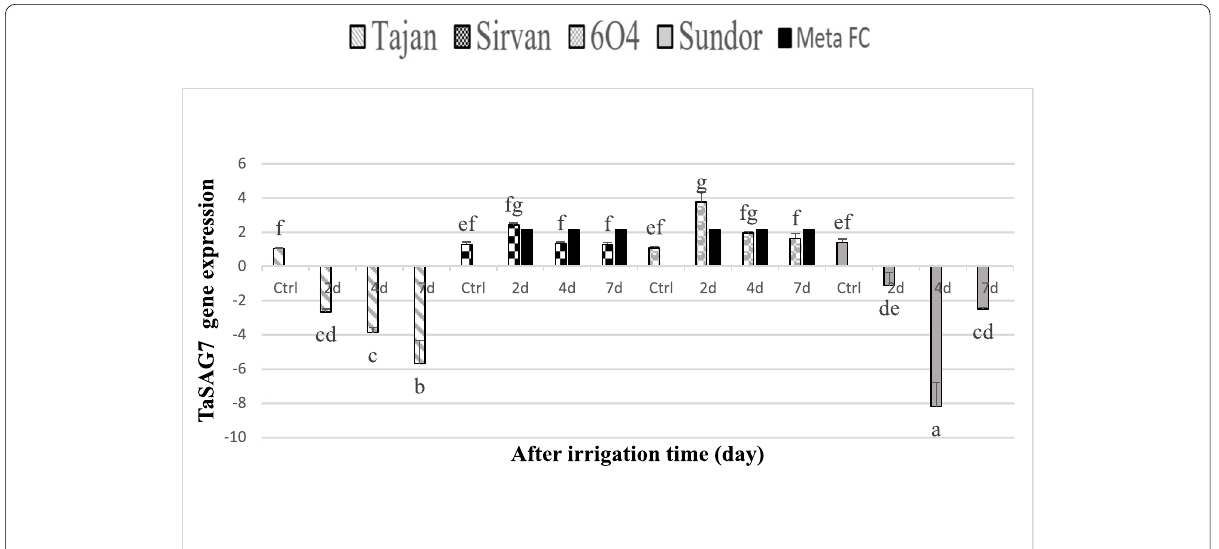
Fig. 9 Expression level of TaSAG7 gene in tolerant wheat (6O4 and Sirvan) and Sensitive wheat (Sundor and Tajan) genotypes at three stress levels 2, 4, and 7 days after drought stress. Based on the results of meta-analysis, this gene has increased only in resistant cultivars. For convenience of comparison, the FC column obtained from the meta-analysis placed next to the resistant